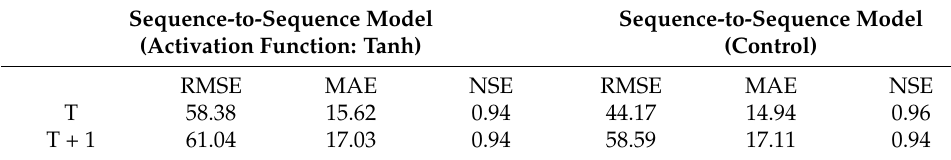
Table 13. Prediction accuracy results after changing activation function to tanh.